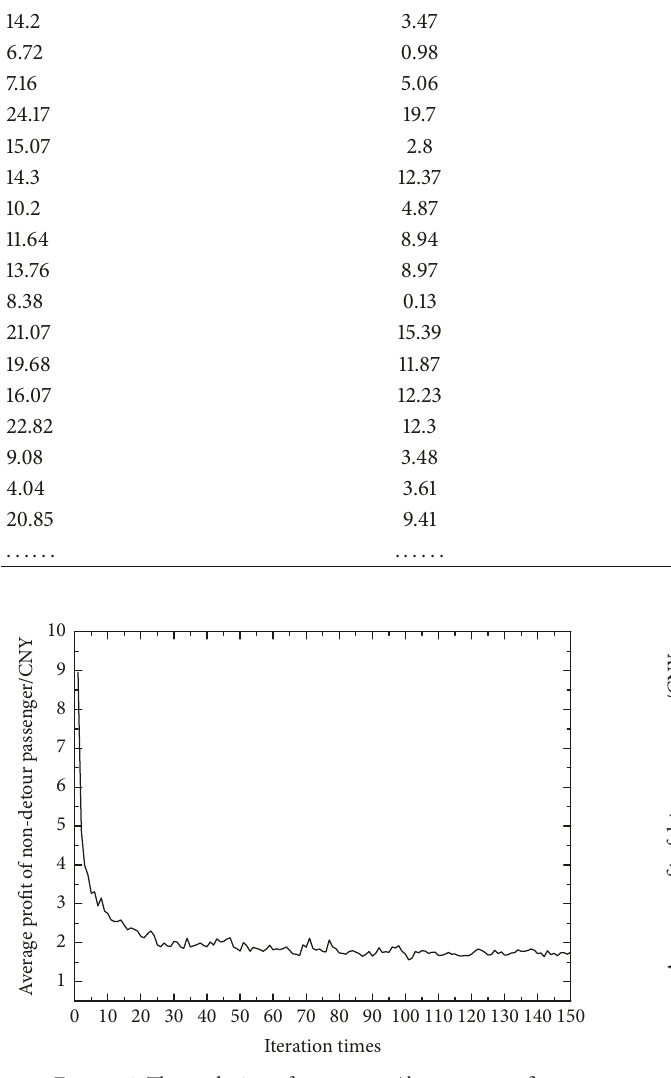
Based on the results of price parameters of carpooling states, the value 𝛼 is shown as Figure 7. The average value of 𝛼 is 0.82. 𝛼 changes around 0.82. That is, the payment ratio of nondetour passenger is 0.82, which is reasonable. It can ensure the realization of carpooling detour. The value 𝛽 is shown as Figure 8. The value 𝛽 ranges from 0.6 to 0.8. Discount coefficient of passenger 𝐵 is smaller than that of passenger 𝐴 due to time delay detour caused. The value 𝛽 should be in the range from 0.6 to 0.8 to ensure the realization of carpooling detour. The relation between 𝐿 𝐷 /𝐿 𝐵 and 𝛽 is shown in Figure 9. /𝐿 𝛽 decreases with the increase of 𝐿 𝐷 𝐵 . It can be seen from the scatter plot that there is an obvious linear relationship between 𝐿 𝐷 /𝐿 𝐵 and 𝛽